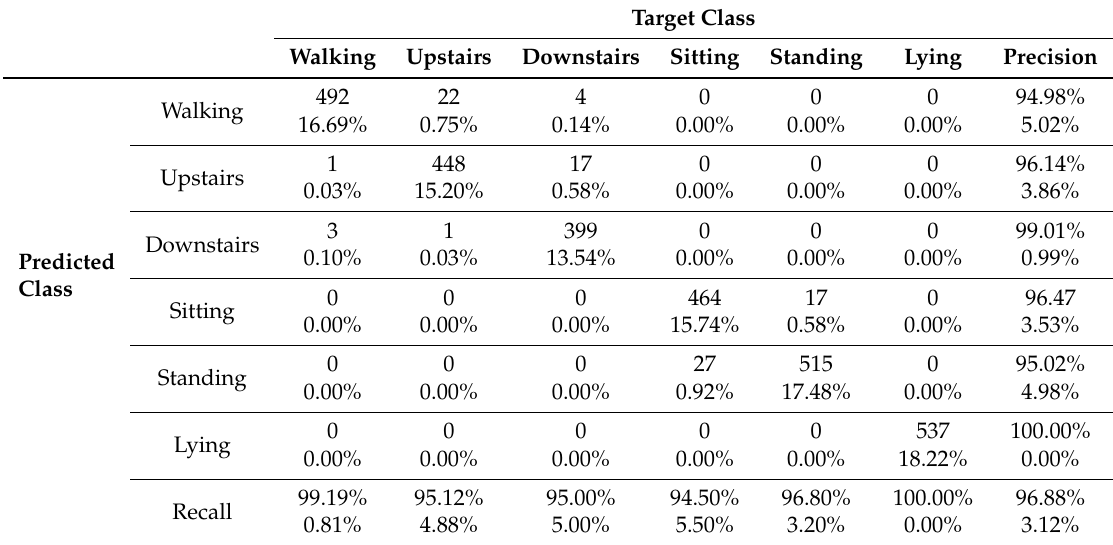
Table 1. Confusion matrix of HAR based on handcrafted feature extraction.